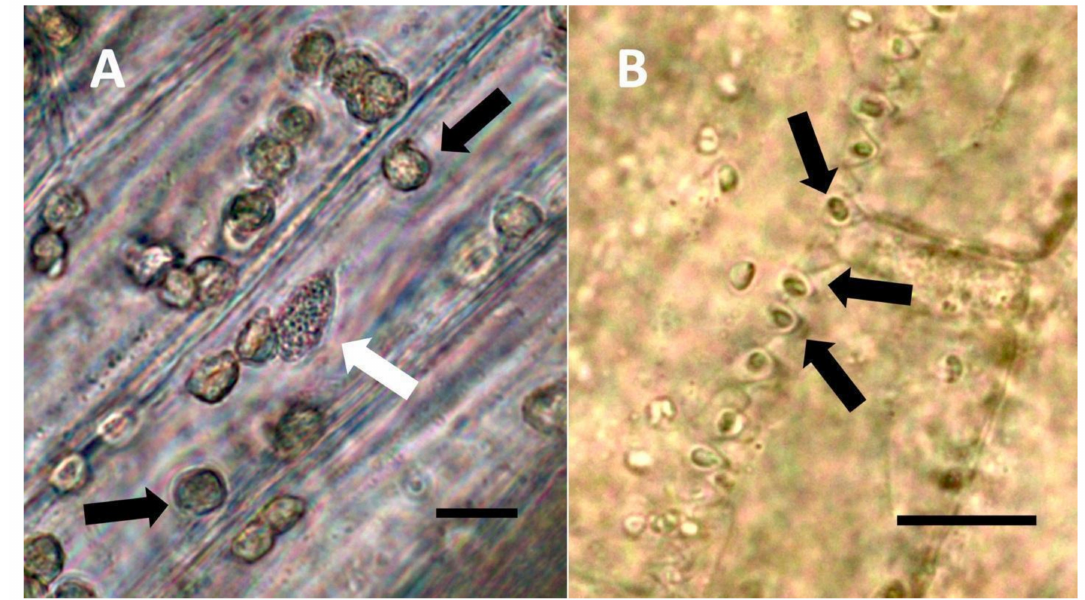
Figure 3. Festuca rubra leaf cells showing bacteria within non-photosynthetic cells. ( A ) Leaf sheath mesophyll cells stained with acidified diphenylamine to show nitrate (purple color) around bacterial masses (black arrows) and in nucleus (white arrow) (Bar = 10 µ m). ( B ) Developing grass epidermal cells stained with nitro blue tetrazolium to show superoxide (blue color) around bacteria (arrows) accumulating in the serrate lateral walls of the cells (Bar = 10 µ m).